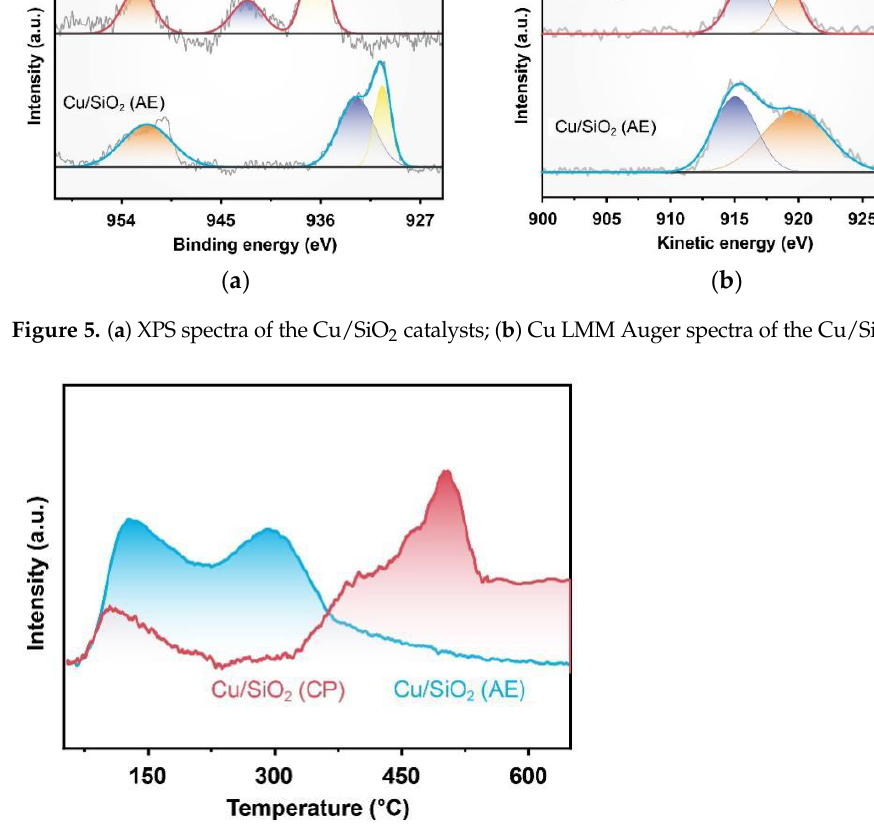
Figure 6. NH 3 -TPD profiles of the Cu/SiO 2 (CP) and Cu/SiO 2 (AE)